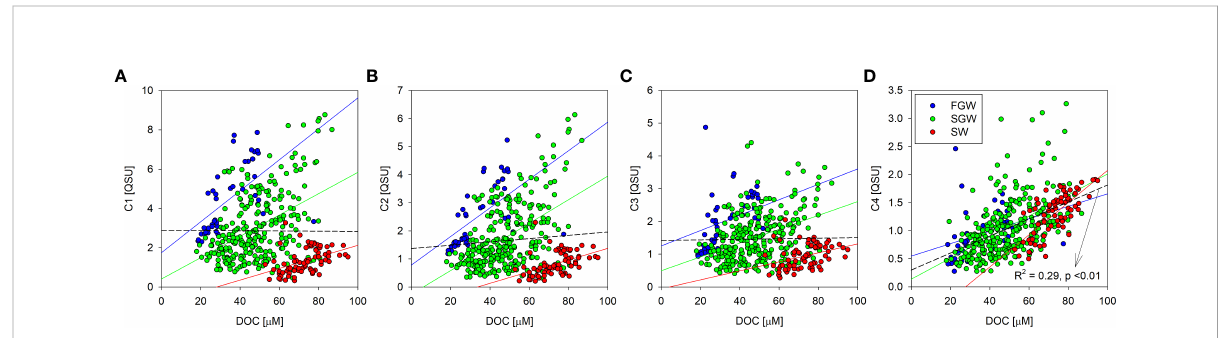
FIGURE 5 Scatterplots between the DOC concentration and the fl uorescent intensities for the FDOM components (C1 (A) , C2 (B) , C3 (C) , and C4 (D) ) in the FGW, SGW, and SW. The blue, green, and red colored lines indicate the regression lines of the FGW, SGW, and SW, respectively. The dashed lines in black indicate the regression lines of the entire